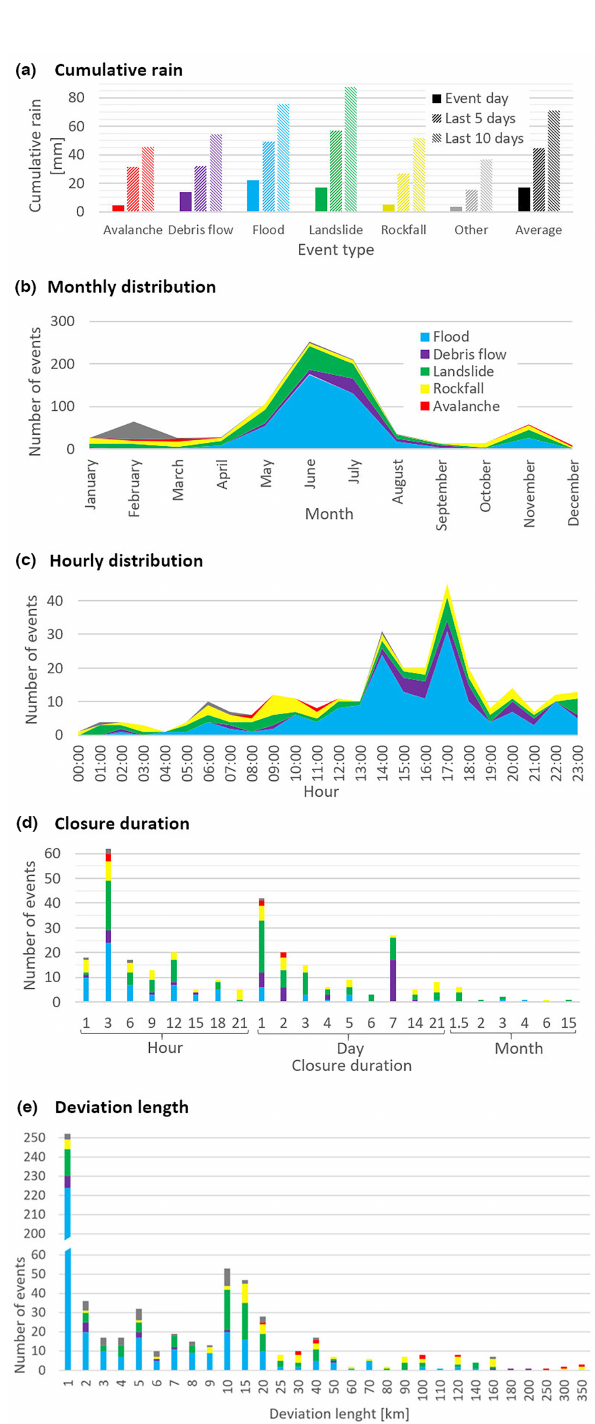
Figure 5. (a) Cumulative rain (mm) distribution on the day of nat- ural hazard events and previous 5 and 10 days. (b) Monthly dis- tribution. (c) Hourly distribution. (d) Closure duration distribution. (e) Shorter deviation length distribution of road closures. The verti- cal axis shows values from 60 to